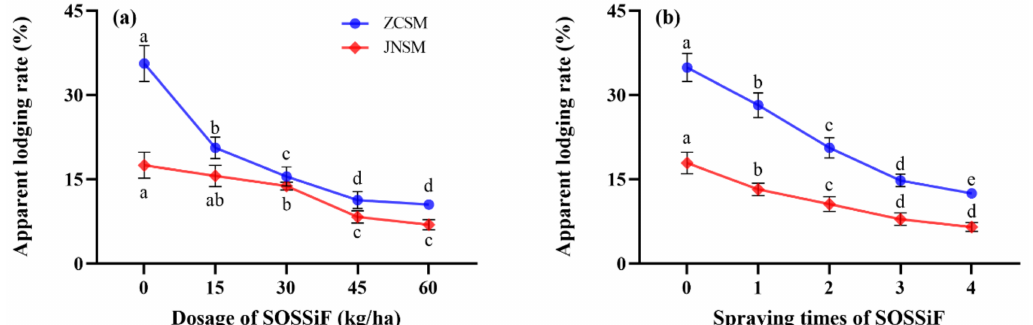
Figure 4. Impacts of Si application rate on apparent lodging rate of rice plants under a high N level. ( a ) different Si dosages, ( b ) spraying times. Different small letters above the data of the same rice variety indicated significant differences.